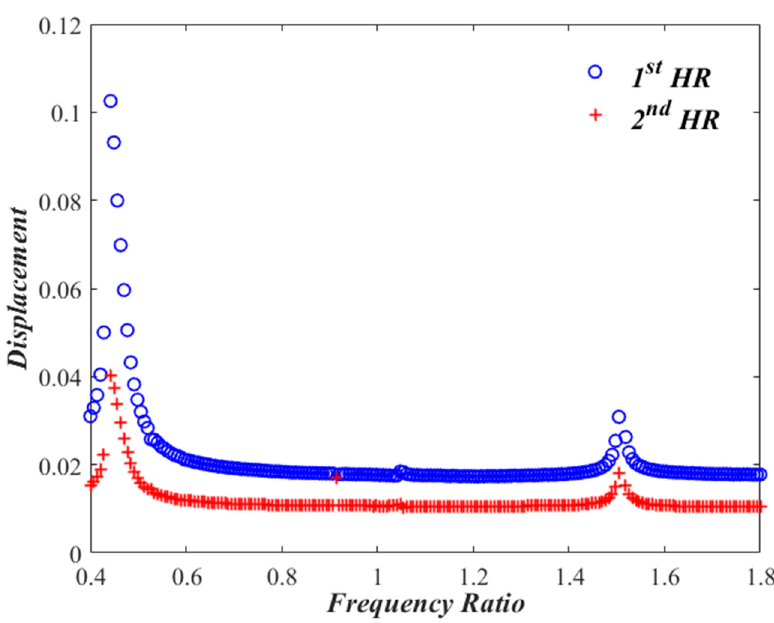
Figure 6. Frequency response curves for 𝑥 (cid:2869),(cid:2870) of the nonlinear dual HR (Case II).